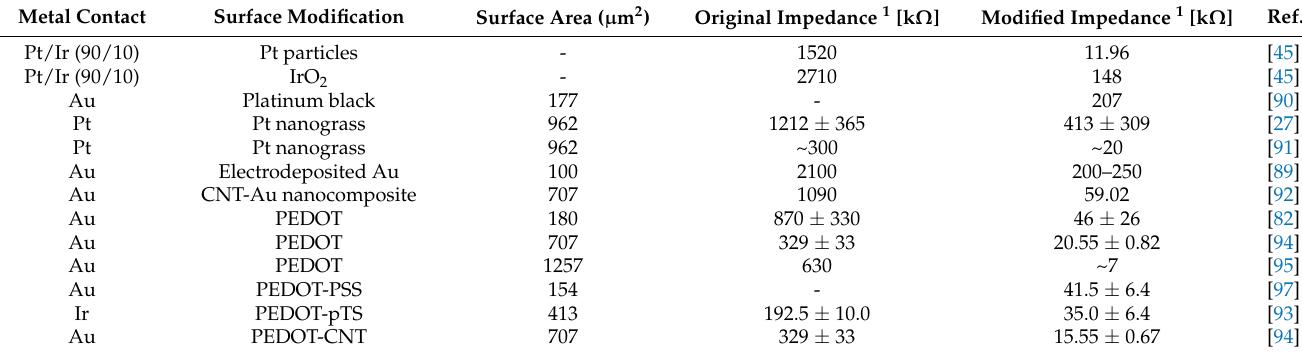
Table 1. Impedance reduction by surface modification of metal